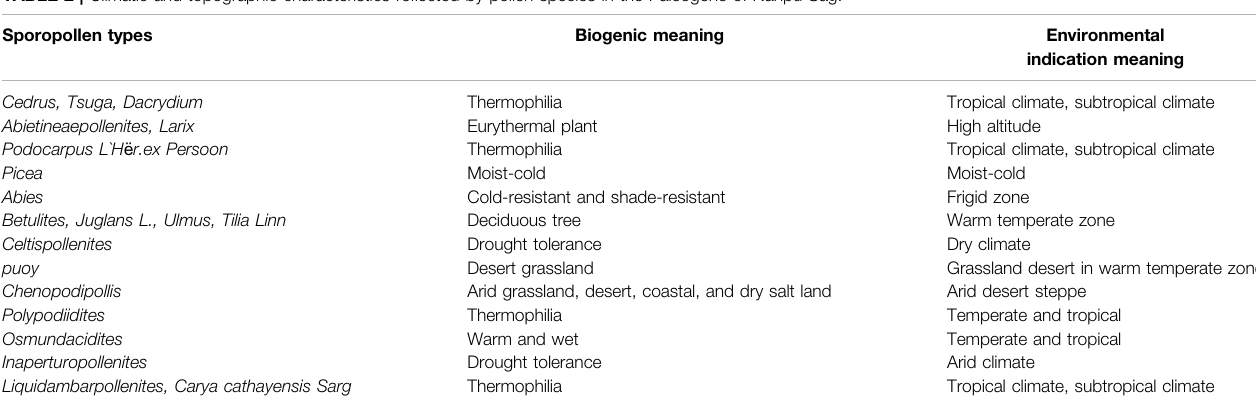
TABLE 2 | Climatic and topographic characteristics re fl ected by pollen species in the Paleogene of Nanpu